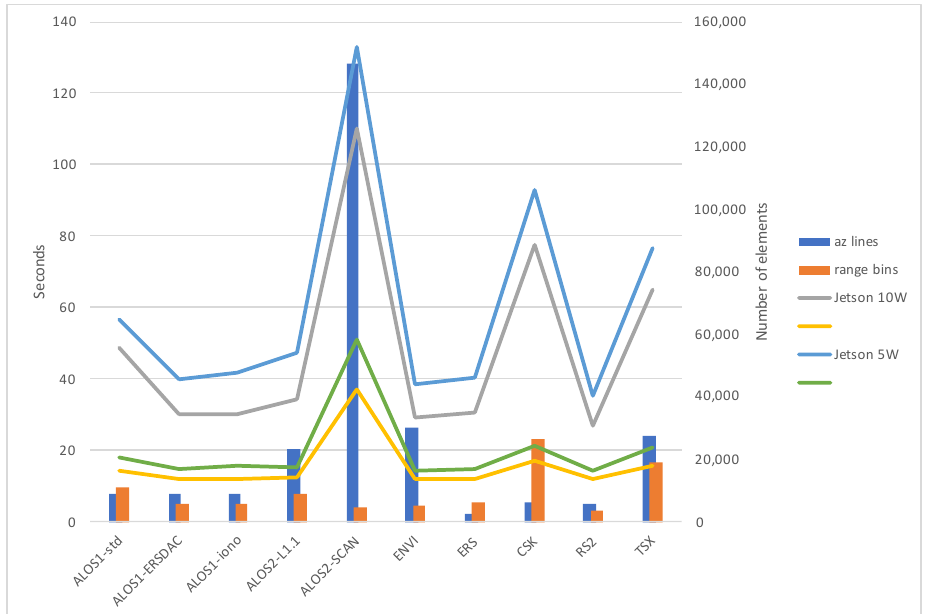
Figure 9. Graphical representation of the execution times for considered datasets on Jetson Nano hardware configuration. Lines represent the values reported in Table 8, bars represent the number of bins in range direction and the number of lines in azimuth direction as reported in Table 1.